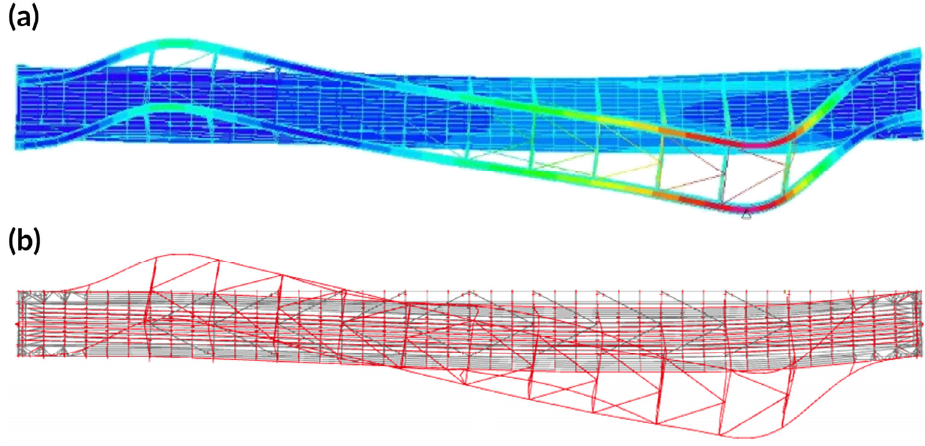
Figure 7. Shape of the first buckling mode of arches obtained by: ( a ) the ADINA “shell” model α cr = 6.0; and ( b ) the SCIA Engineer “beam” model α cr = 6.2.